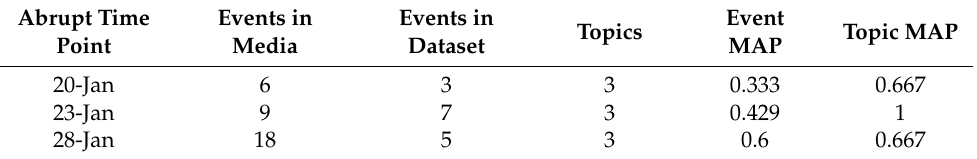
Table 5. The Ranking Comparison of Events and Emotional Paths.